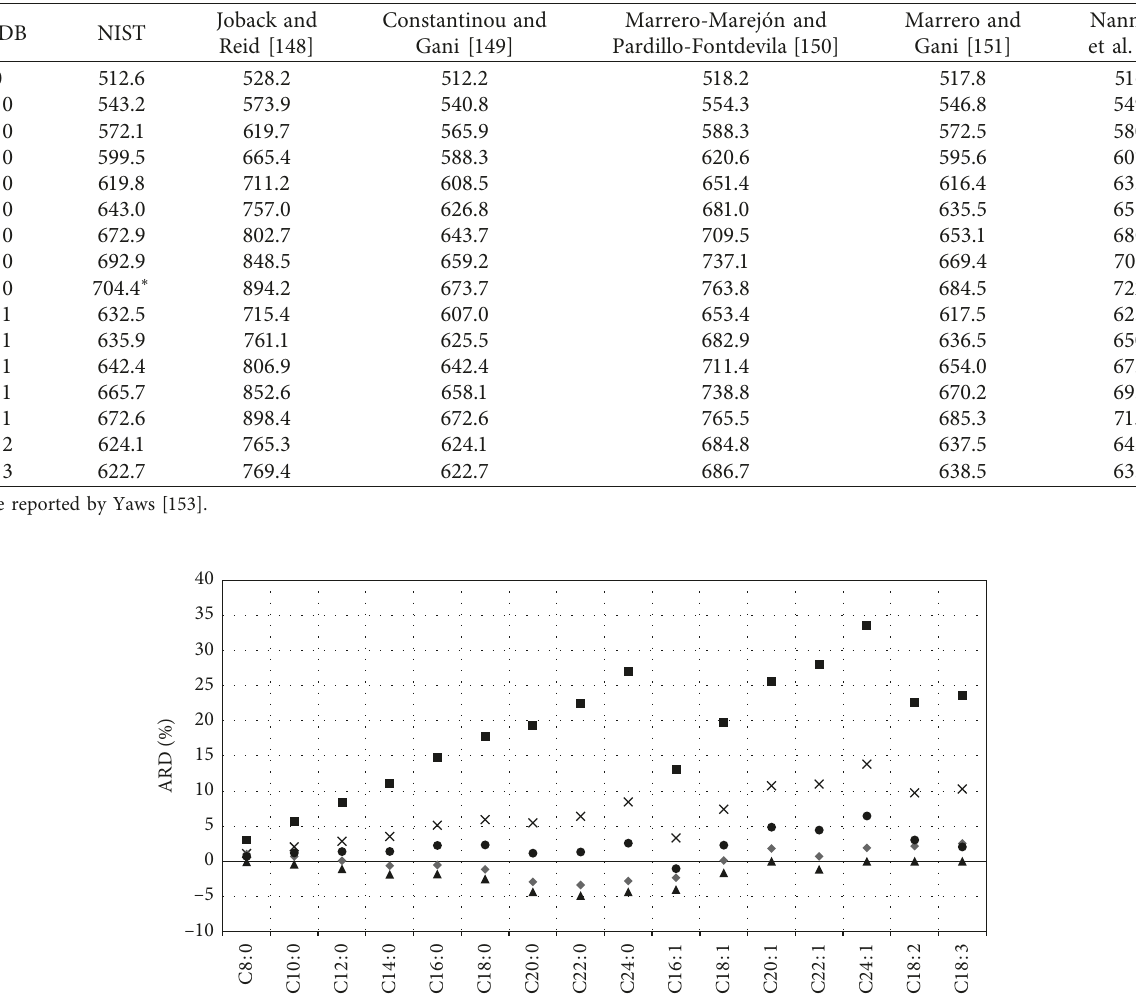
Table 4: Comparison of experimental and estimated normal boiling temperature (K).